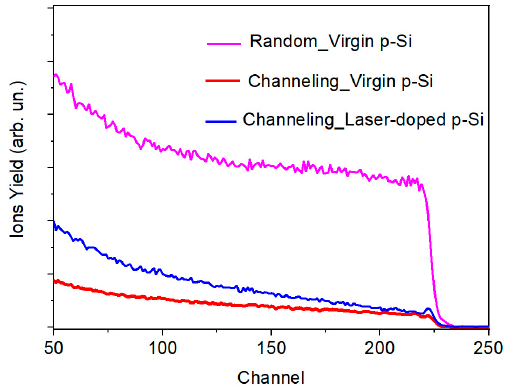
Figure 3. Random and aligned (channeling along <100>) RBS spectra measured for p-Si crystal before and after pulsed laser P doping. For virgin and laser-doped Si, random spectra coincided.